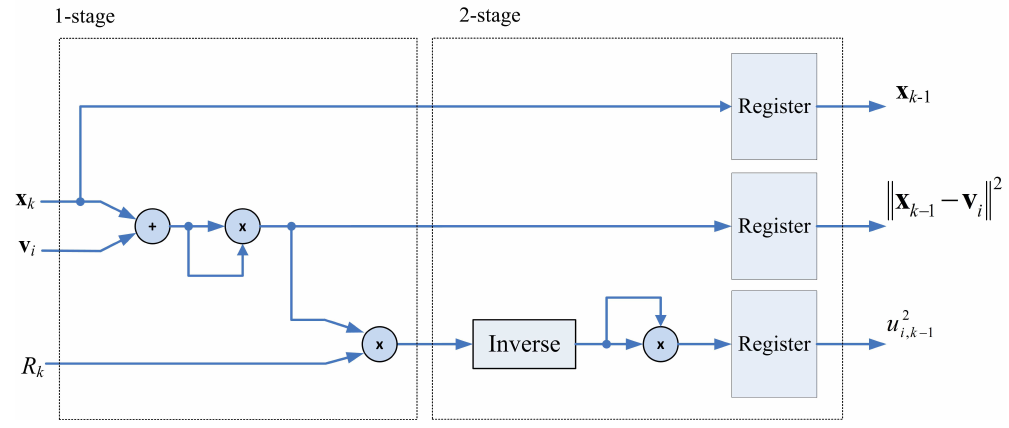
Figure 5. The architecture of membership coefficients computation unit.